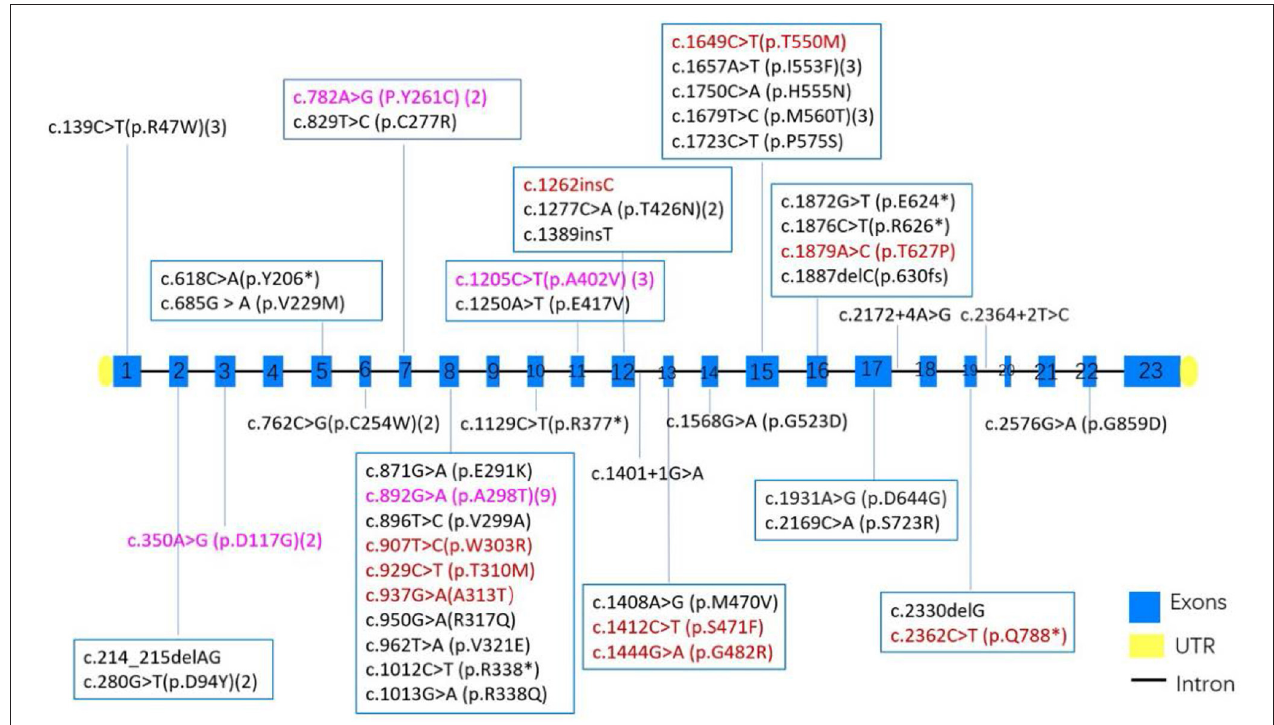
FIGURE 3 | The distribution of exons and variants in 43 MC patients from China. Variants colored red have been observed to be AD inherited, black indicates AR inheritance, and purple suggests both AD and AR inheritance had been observed in the variants. Numbers after some variant showed the times of each variant found in 43 MC